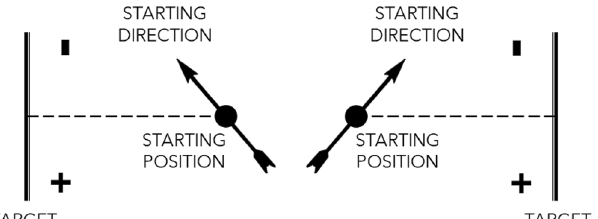
Figure 2. Schematic representation of the logic behind the final arrow position sign assignment. The sign was negative if the arrow ended its run in the same hemi-field from which it started, in other words if it undershot the target; it was positive otherwise. The scheme shows two arrow-target configurations. In absolute coordinates, the final arrow position signs should be positive above the target center in one configuration and positive below in the other. Instead, since the arrows start oriented towards the upper hemi-field in both the configurations, the positive signs lie below the target center in both the